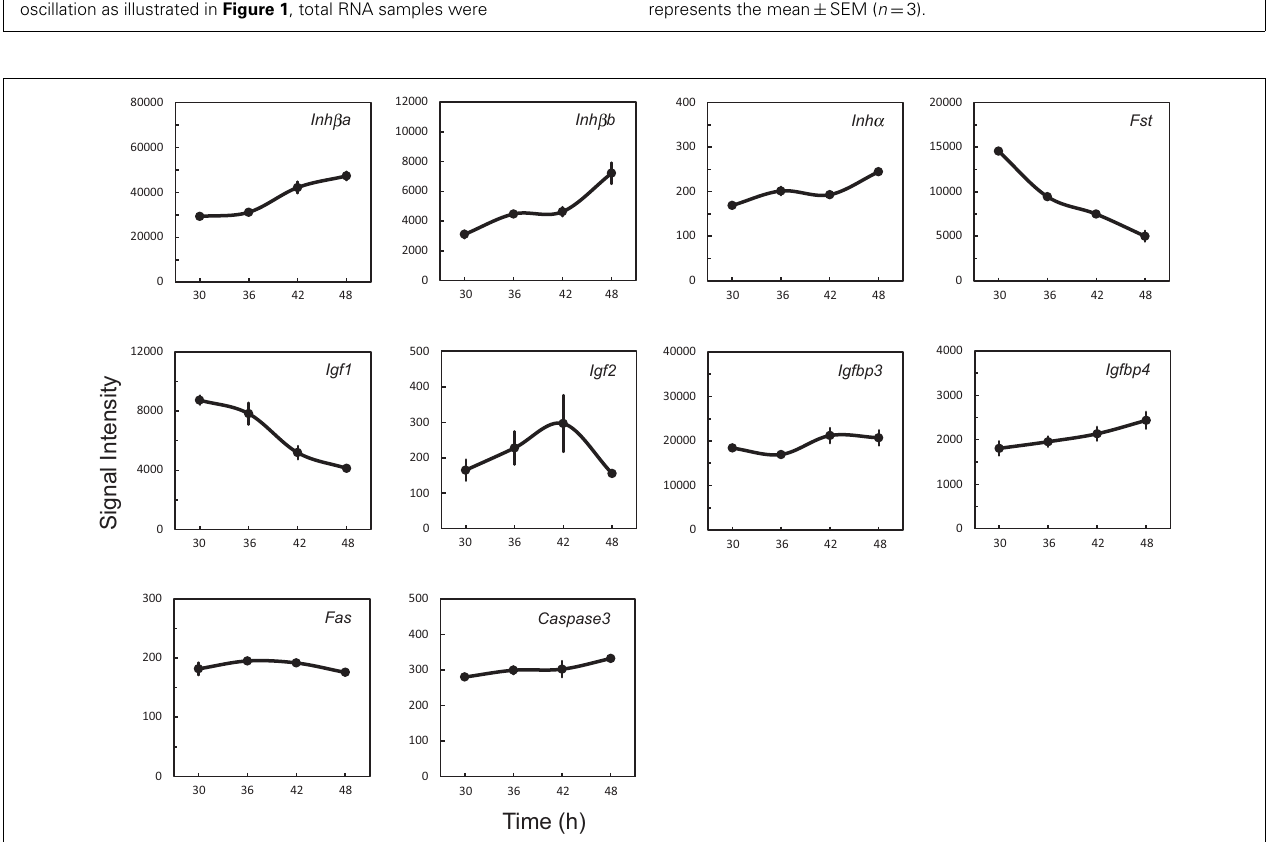
collected at the indicated times after synchronization. qRT-PCR analyses of transcript levels were performed using their specific primers. Gapdh was used as an internal control. Each value represents the mean ± SEM ( n = 3).